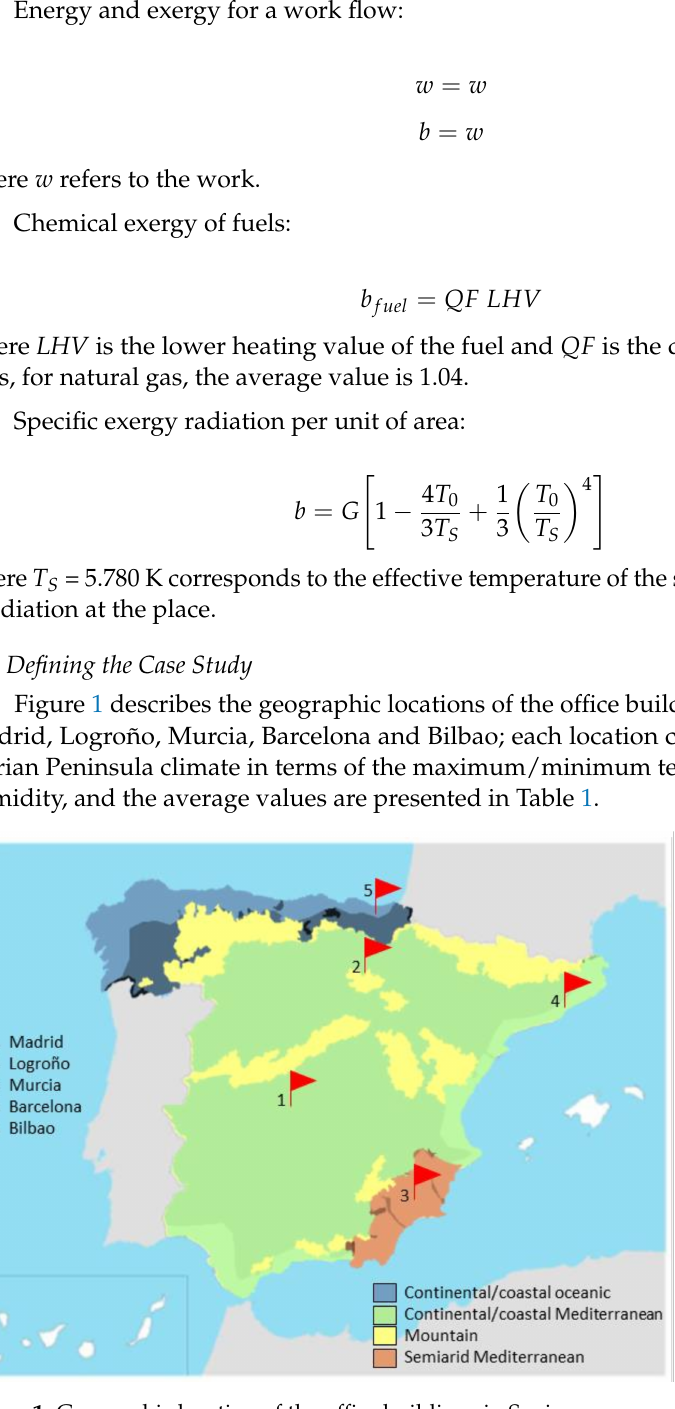
Figure 1. Geographic location of the office buildings in